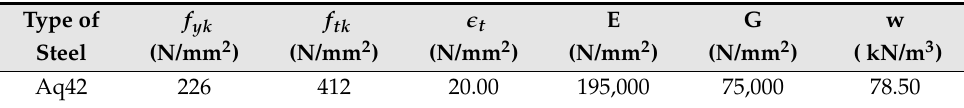
Table 3. Mechanical characteristics of